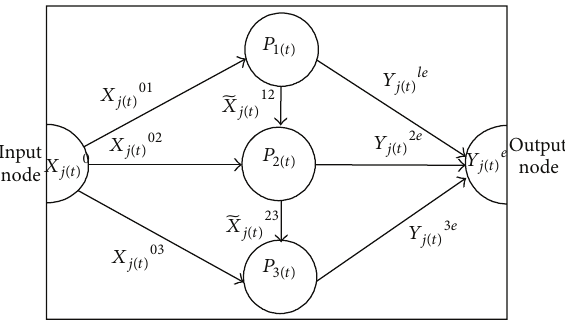
Figure 6: DN-DEA with 3 sub-DMUs in the one time span.